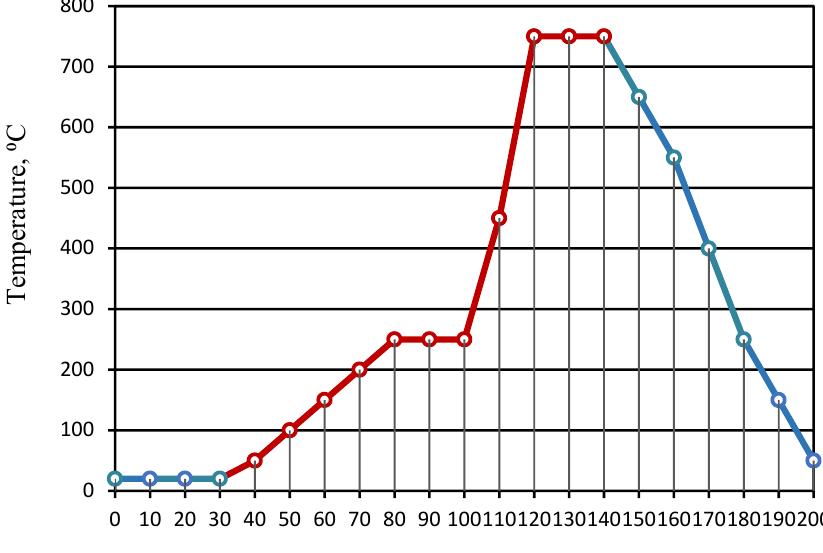
Figure 6. Mode of heat treatment of the granules: 1—pre-drying of raw granules; 2—heating to a temperature of 250 ◦ C; 3—isothermal heating at a temperature of 250 ◦ C (preliminary foaming); 4—heating to a temperature of 750 ◦ C; 5—isothermal heating at a temperature of 750 ◦ C (foaming); 6—cooling.